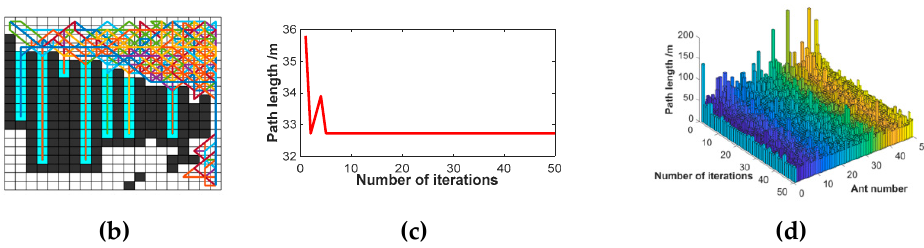
Figure 15. Diagram of the optimal path of this paper; ( a ) Optimal path diagram; ( b ) All ants’ paths diagram; ( c ) Iterative diagram of the optimal path; and ( d ) Iterative diagram of ants’ paths. The simulation results show that the retraction strategy preserves all the ants’